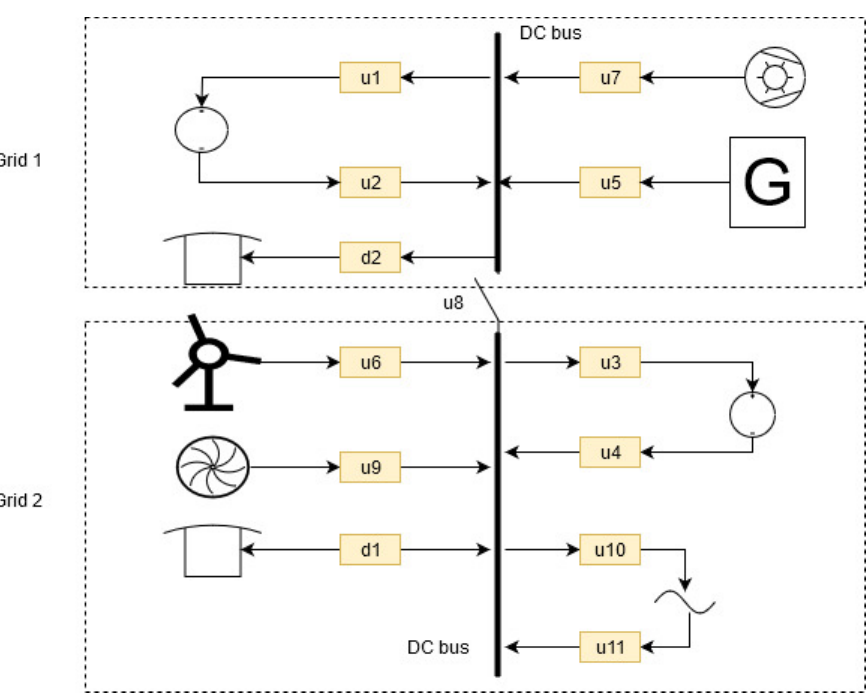
Figure 1. Block diagram of the smart